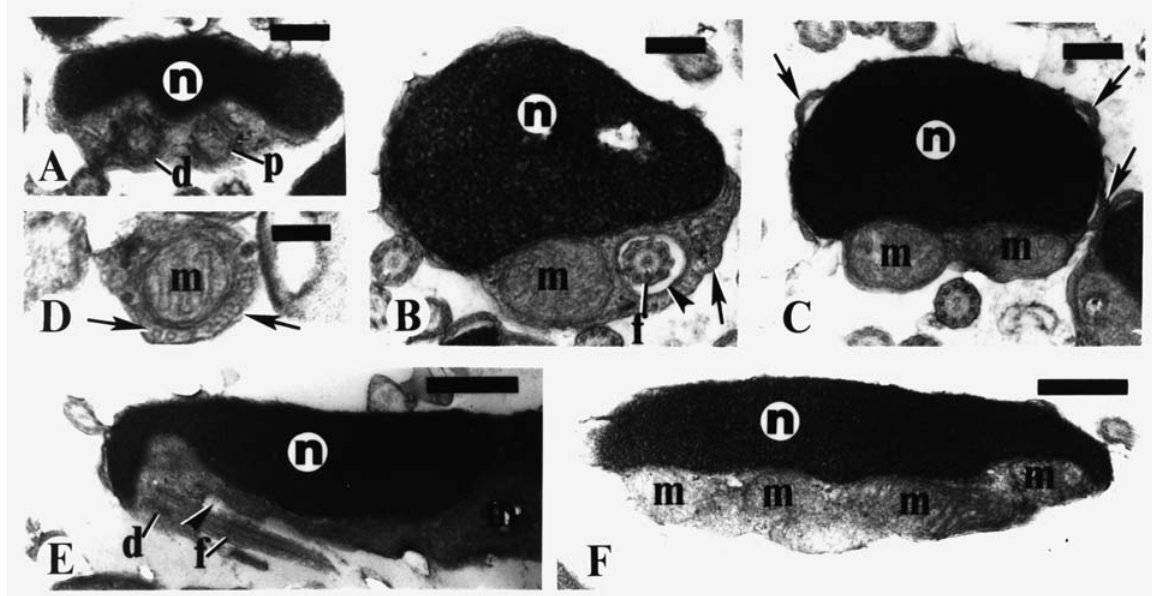
Fig. 18. Transmission electron micrographs through spermatozoa from mature male Bryconadenos tanaothoros , SL 50.0 mm (USNM 352061). A-D, successively more posterior transverse sections; E-F, longitudinal sections. Symbols: n, nucleus; m, mitochondrion; p, proximal centriole; d, distal centriole; f, flagellum, arrows, accessory microtubules; arrowheads, cytoplas- mic canal of collar. Bars: A-C, 0.2 µ m; D, 0.1 µ m; E-F, 0.5 µ